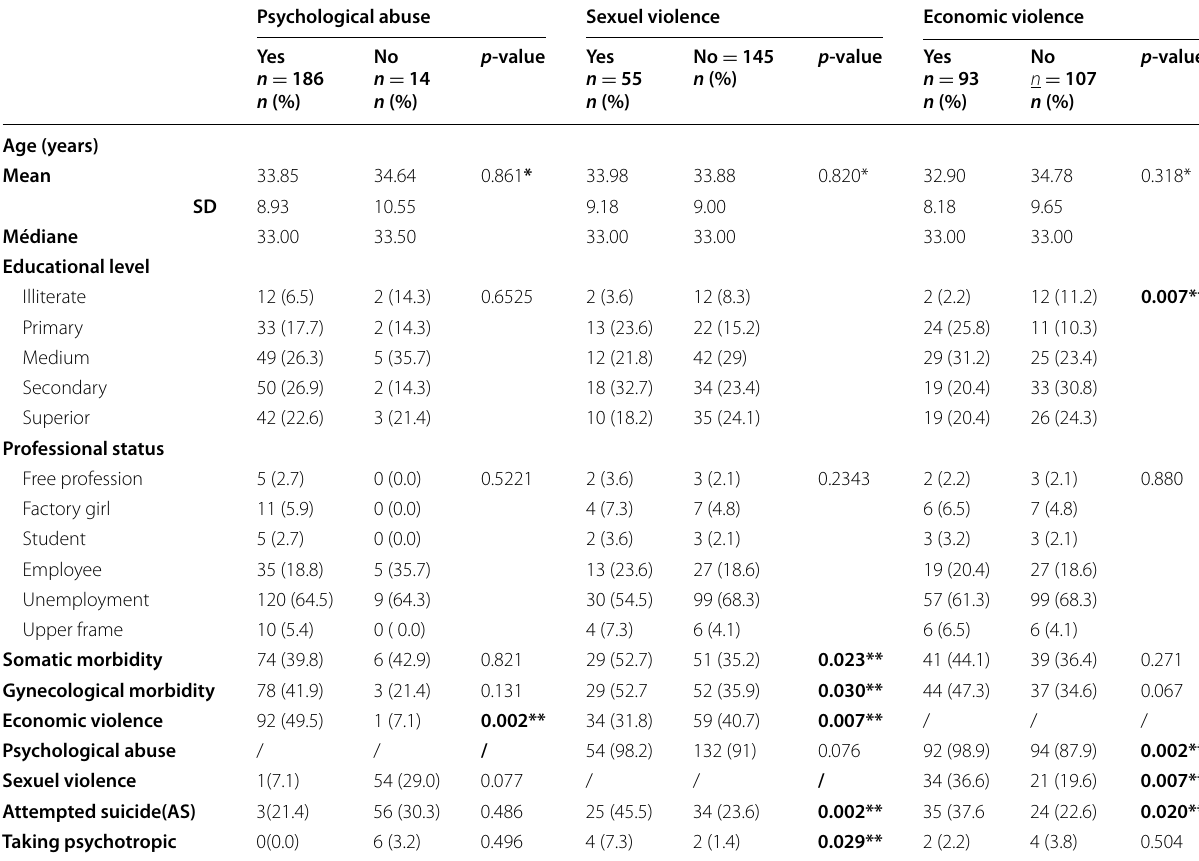
Table 5 Risk factors for psychological abuse, sexual violence, and economic violence according to sociodemographic characteristics, somatic, gynecological, and mental morbidity of